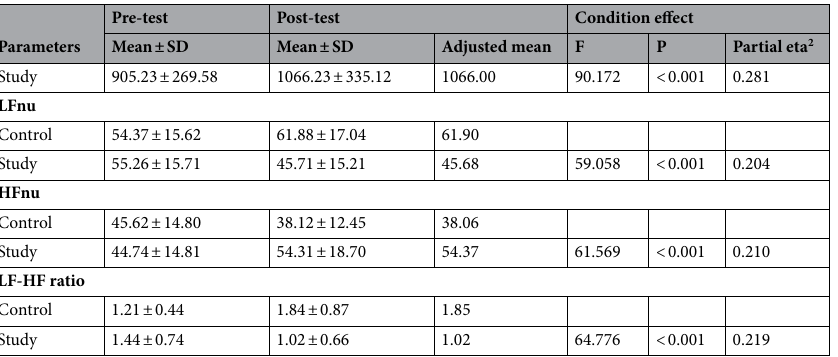
Table 4. Descriptive statistics and ANCOVA results of Post-Test (after 20 weeks of intervention) anthropometric, heart rate, blood pressure, HRV and BPV parameters between the control (pregnant women with risks of GH receiving routine standard antenatal care alone) and study group (pregnant women with risks of GH receiving routine standard antenatal care + Yoga) subjects. Pre-Test: recordings before intervention, at 16th week; Post-Test: recordings after 20 weeks of intervention, at 36th week. Comparison of data between the Control (Post) and Study (Post) was done by analysis of covariance (ANCOVA). The p value < 0.05 was statistically considered significant. * Data presented are median (inter-quartile range) and adjusted median. BMI body mass index, BHR basal heart rate, SBP systolic blood pressure, DBP diastolic blood pressure, MAP mean arterial pressure, RPP rate pressure product, SV stroke volume, LVET left ventricular ejection time, CO cardiac output, TPR total peripheral resistance, BRS baroreflex sensitivity, SDNN standard deviation of the averages of NN intervals, RMSSD square root of the mean of the sum of the squares of differences between adjacent NN intervals, NN50 number of interval differences of successive NN intervals greater than 50 ms, pNN50 proportion derived by dividing NN50 by the total number of NN interval, TP total power of HRV, LFnu normalized low frequency component, HFnu normalized high frequency component, LF-HF ratio ratio of LF to